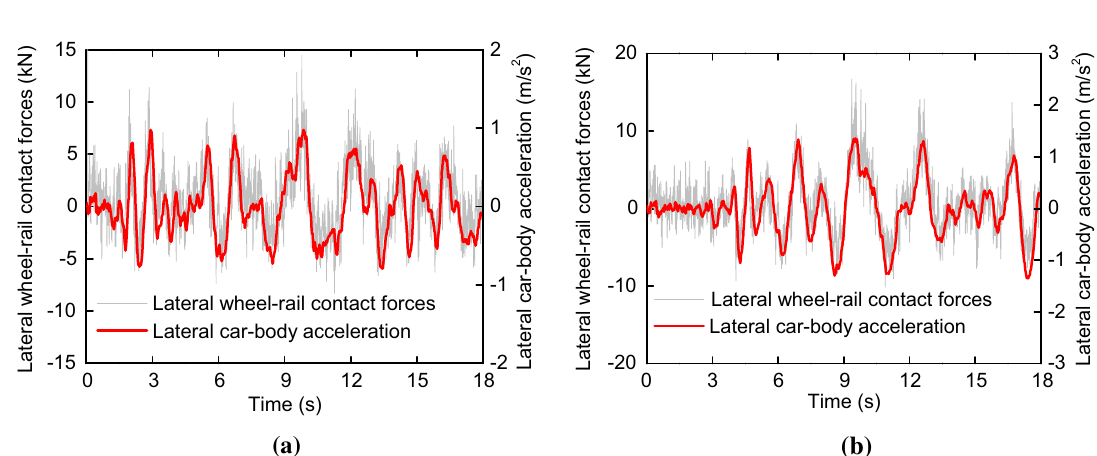
Fig. 15 Comparison between the lateral wheel–rail contact forces and the lateral car-body acceleration: a case 2; b case